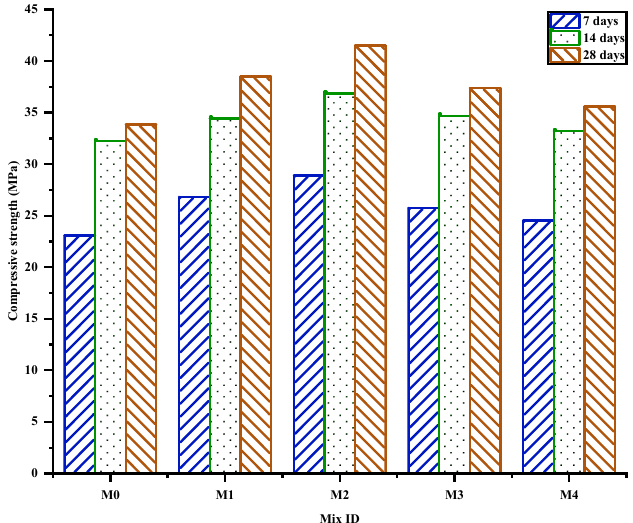
Figure 2. The compressive stress of fine-grained cementitious composites for five different mixes.